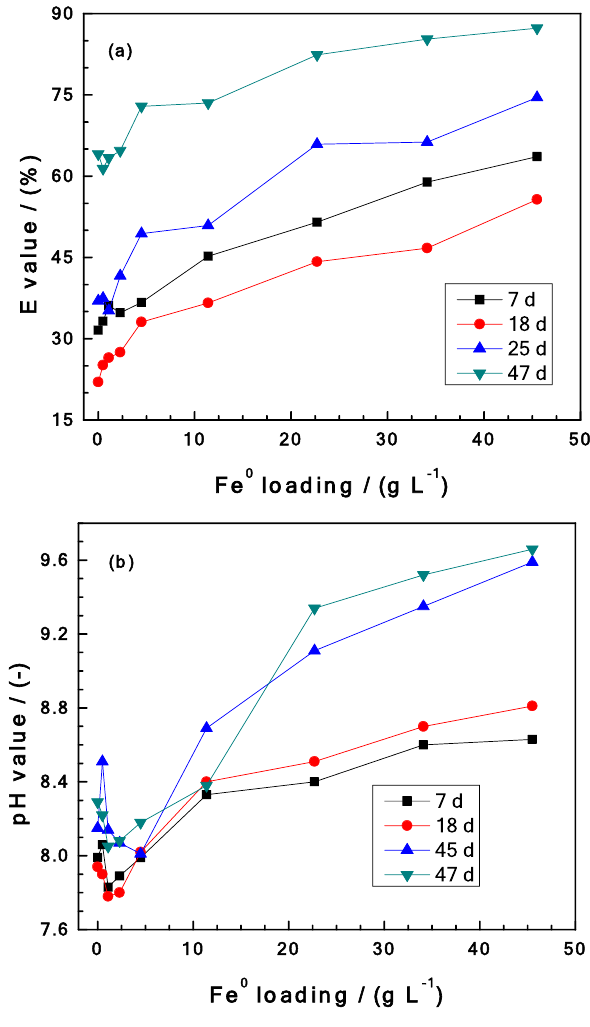
Figure 3. Changes in Fe 0 /sand/MnO 2 systems as impacted by the addition of various Fe 0 loading for 7, 18, 25 and 47 days: ( a ) Methylene blue discoloration, and ( b ) pH value. Experimental conditions: [Fe 0 ] = 2.3 to 45